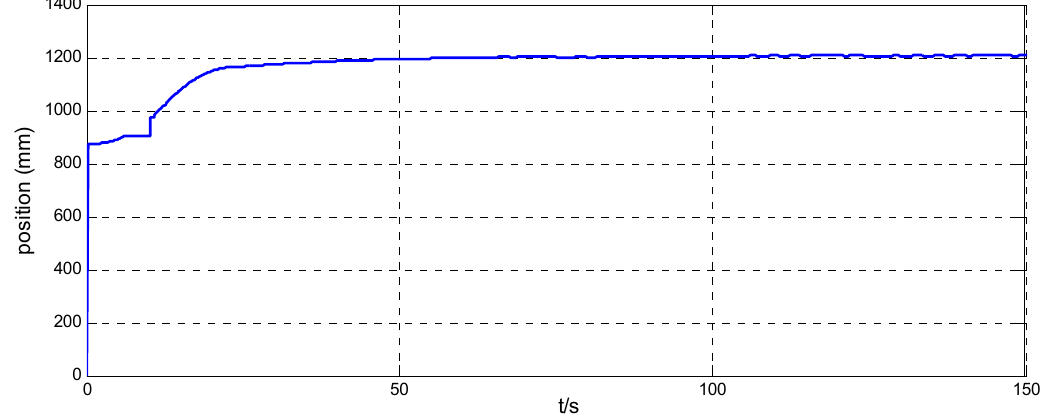
Figure 18. Position along the x-axis of the simulator when x ( 0 ) = 874mm.